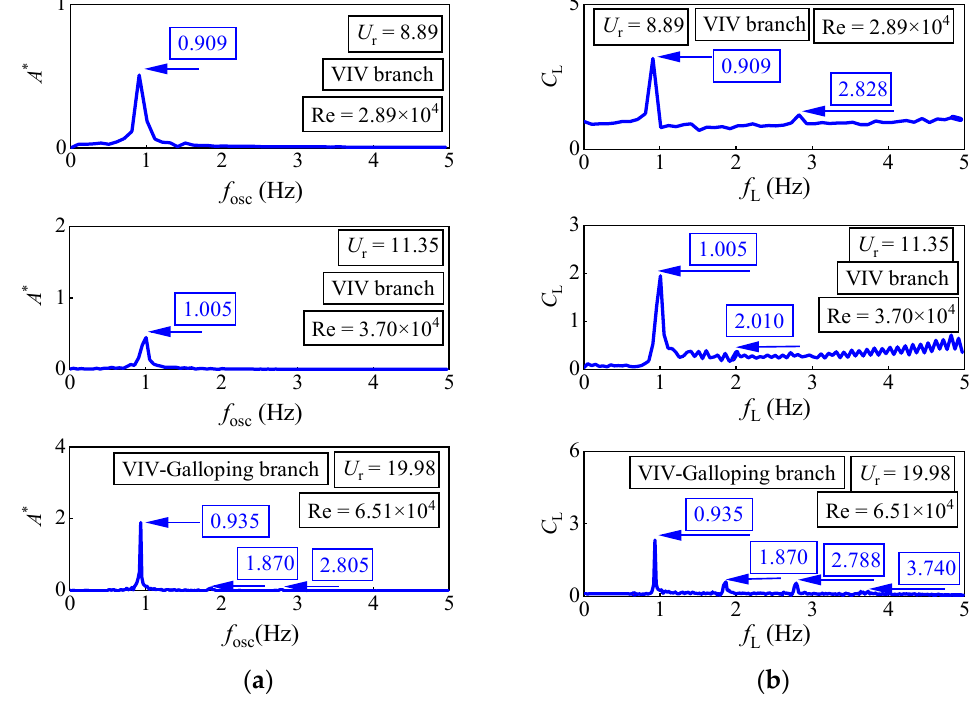
Figure 12. Spectral of Cir-T-Att with D = 0.06 m, R e = 2.89 × 10 4 ~6.51 × 10 4 . ( a ) Displacement spectral. ( b ) Fluid force spectral.